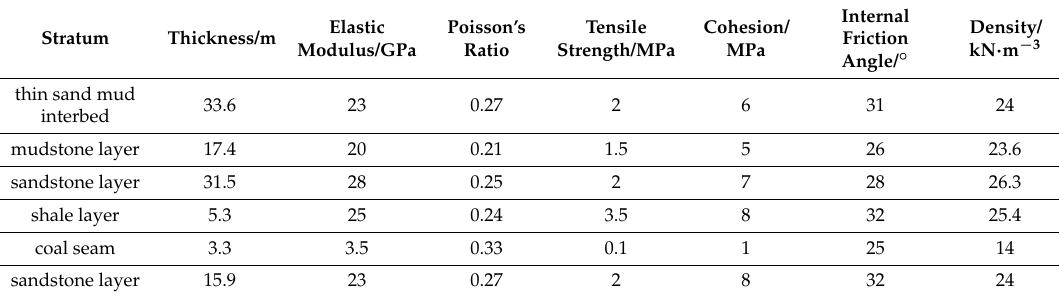
Table 1. Mechanical parameters of coal and rock strata.